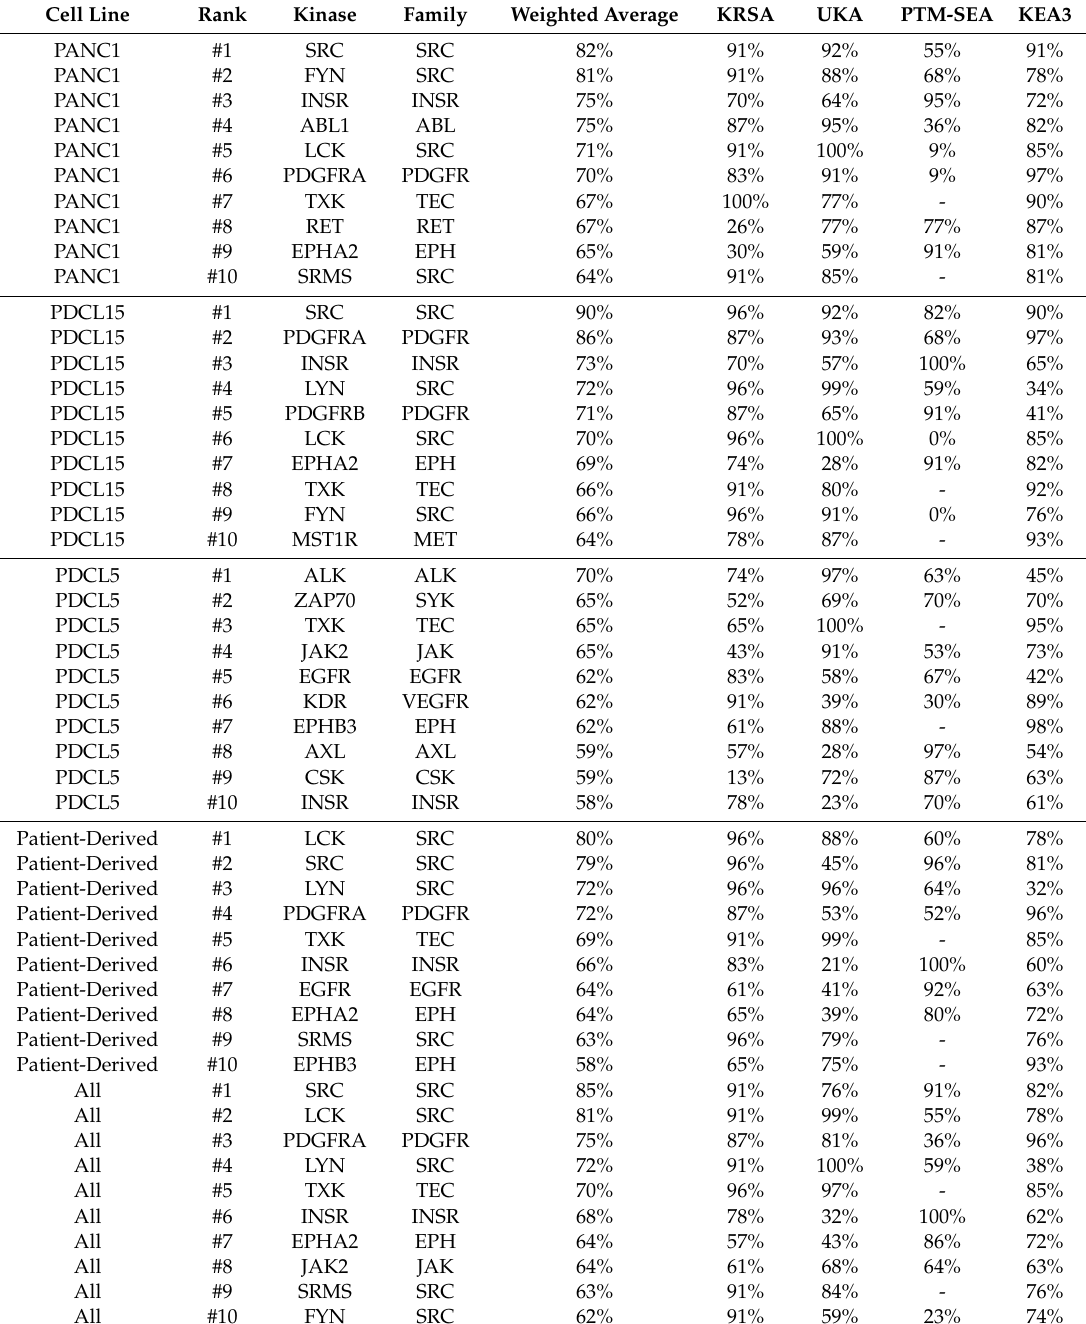
Table 4. All pipelines’ (KRSA, UKA, PTM-SEA, and KEA3) weighted average percentile rankings. Cell